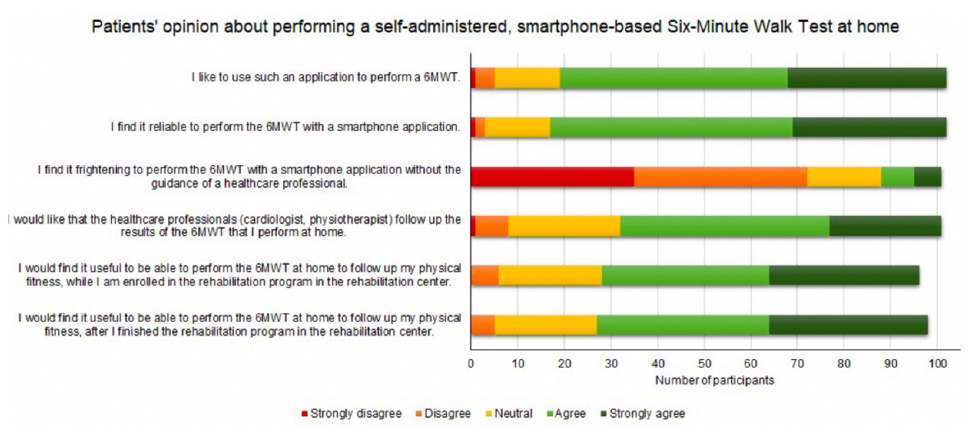
Figure 7. Cardiovascular disease patients’ opinion about the six-minute walk test (6MWT).